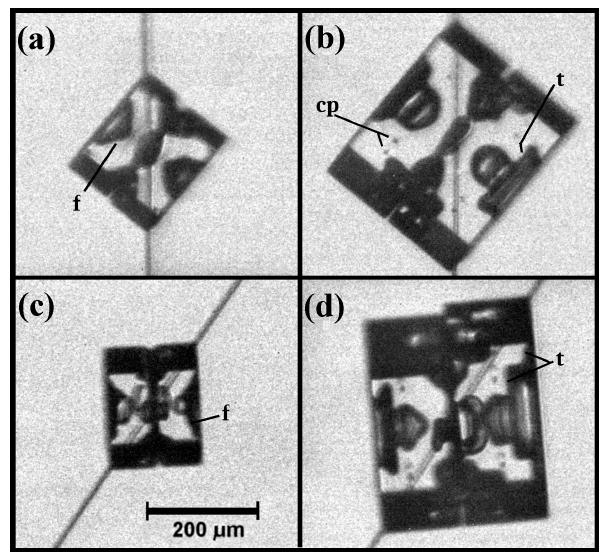
Figure 12. Center hollow terracing on twinned crystals grown at about − 30 ◦ C and 5% supersaturation. (a) Side view of crystal in middle of one capillary, basal faces pointing NW and SE; f marks “fanning-out” structure of a center hollow (ditto in c ). (b) Crystal in (a) , but 46h later; t marks terrace feature (ditto for d ). (c) Dif- ferent crystal under the same conditions but on a different capillary. (d) Same crystal as (c) but 47h later. The small corner pockets (e.g., “cp”) appear in (b) and (d) due to a sublimation period after images in (a) and (c) . Scale in (c) applies to all